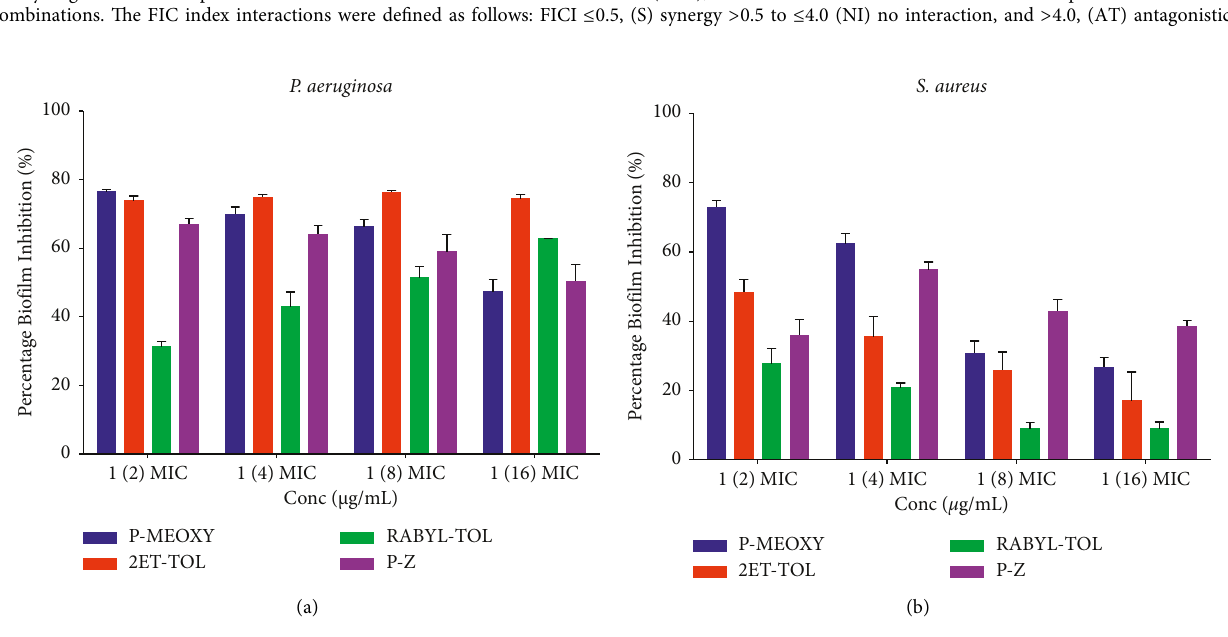
Figure 3: (a) Biofilm inhibition effect caused by test compounds against P. aeruginosa . Concentrations of RABYL-TOL and P-Z (1/2 MIC: 0.9750 µ g/mL, 1/4 MIC: 0.4875 µ g/mL, 1/8 MIC: 0.2438 µ g/mL, and 1/16 MIC: 0.1219 µ g/mL). P-MEOXY [1/2 MIC:1.9500 µ g/mL, 1/4 MIC: 0.9750 µ g/mL, 1/8 MIC: 0.4875 µ g/mL, and 1/16 MIC: 0.2438 µ g/mL]. 2ET-TOL [1/2 MIC: 0.00625 µ g/mL, 1/4 MIC: 0.003125 µ g/mL, 1/8 MIC: 0.0015625 µ g/mL, and 1/16 MIC: 0.00078125 µ g/mL]. (b) Biofilm inhibition effect caused by test compounds against Staphylococcus aureus . Concentrations of P-MEOXY and P-Z (1/2 MIC: 250 µ g/mL, 1/4 MIC: 125 µ g/mL, 1/8 MIC: 62.5 µ g/mL, and 1/16 MIC: 31.25 µ g/ mL). RABYL-TOL (1/2 MIC: 125 µ g/mL, 1/4 MIC: 62.5 µ g/mL, 1/8 MIC: 31.25 µ g/mL, and 1/16 MIC: 15.625 µ g/mL). 2ET-TOL (1/2 MIC: 15.625 µ g/mL, 1/4 MIC: 7.8125 µ g/mL, 1/8 MIC: 3.90625 µ g/mL, and 1/16 MIC: 1.953125 µ